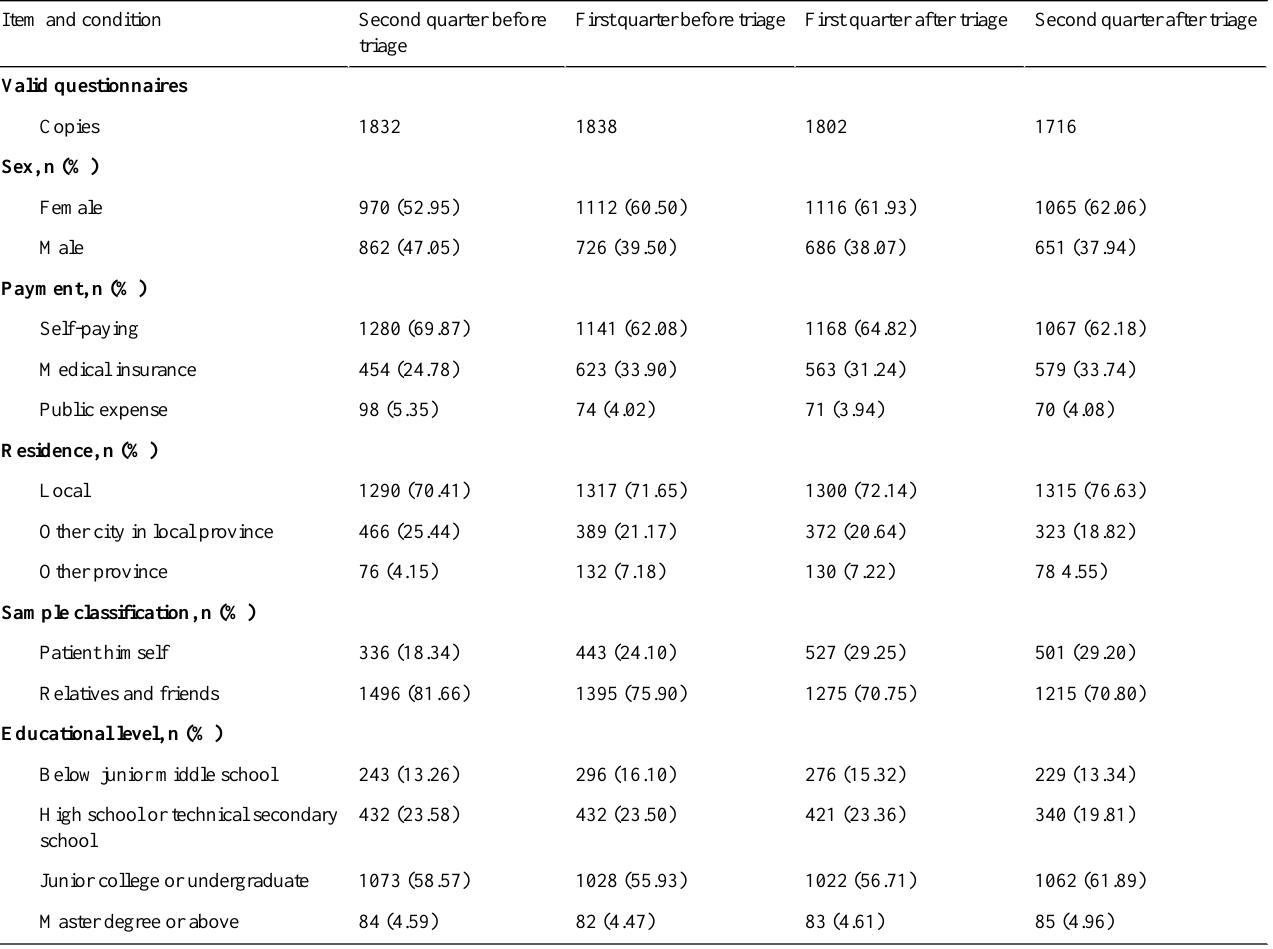
Table 2. Basic information of the degree of patient satisfaction before and after smartphone-based triage.